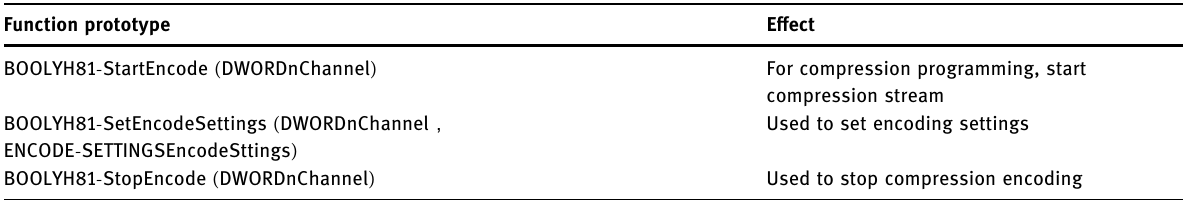
Table 4: Video encoding functions Function